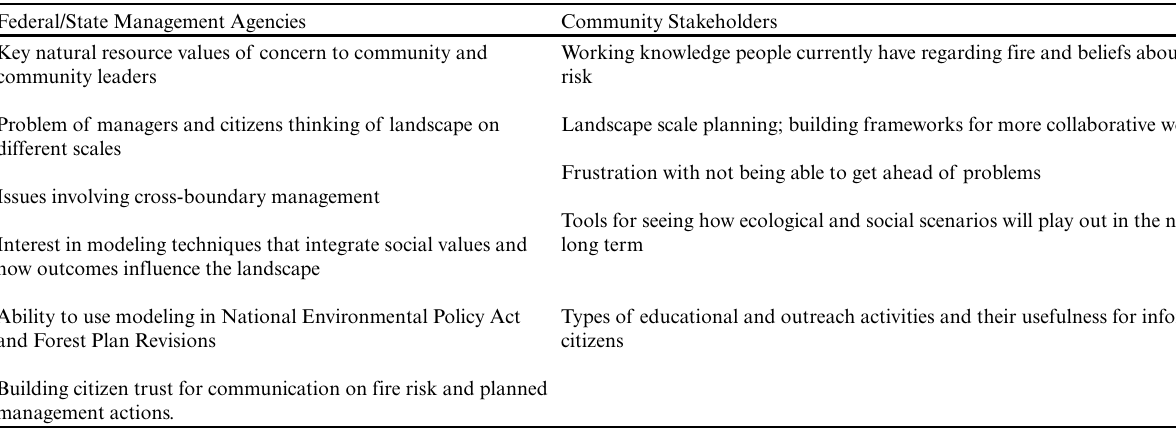
Table 1 . Important points of interest to agency and stakeholder groups in the study